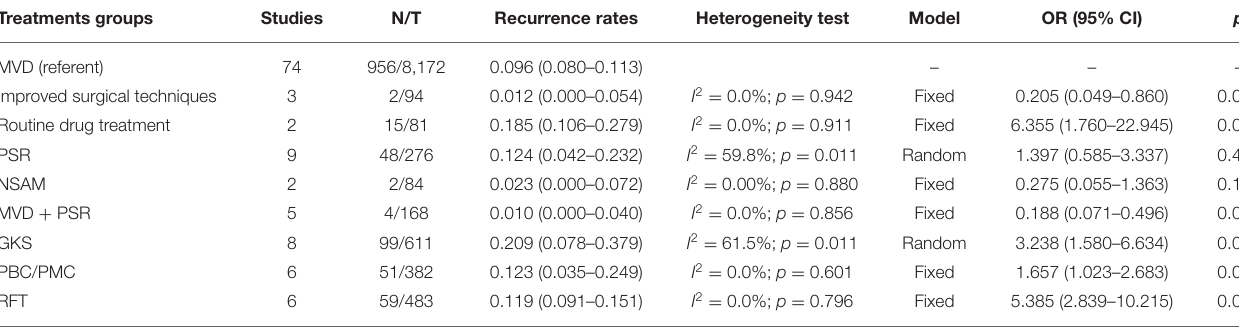
TABLE 3 | Comparison of the recurrence rates of different treatments for primary trigeminal neuralgia. Treatments